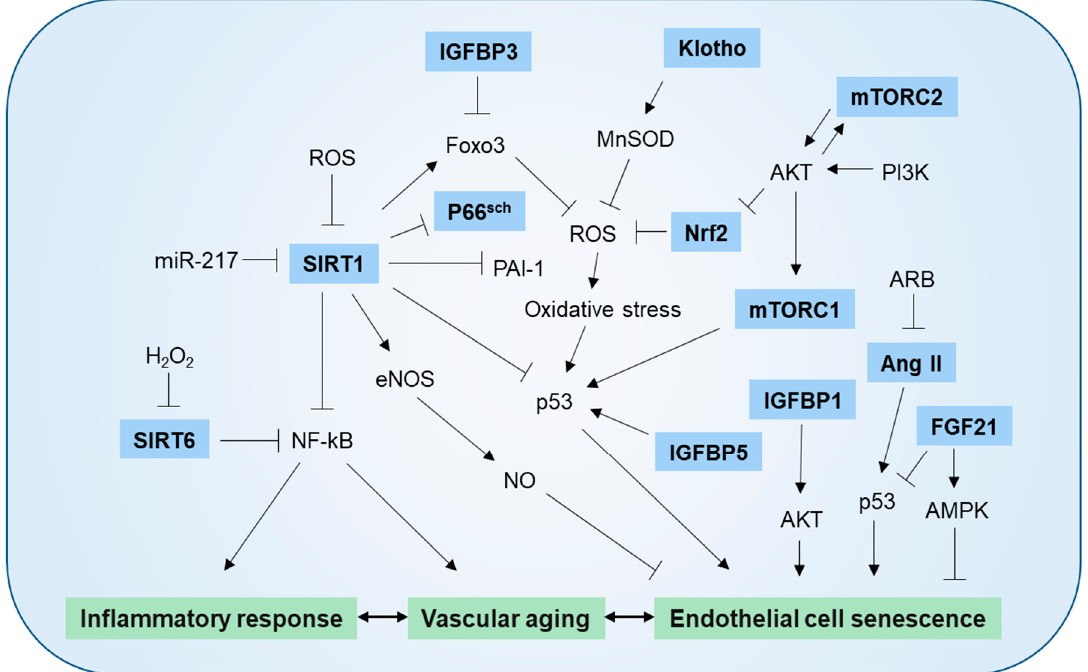
Figure 2. Molecular mechanism mediating endothelial cell senescence and vascular aging. SIRT1 protects against endothelial dysfunction by deacetylating eNOS and increasing endothelial NO bioavailability. SIRT1 also protects vascular inflammation by suppressing NF- κ B signaling and exerts anti-oxidant action by increasing Foxo and down-regulating p66shc. Under conditions of age-related overexpression, miR-217 suppresses SIRT1 production. Klotho increases MnSOD activity and NO availability by negatively downregulating IGF-1 signaling. H2O2 induces endothelial cell (EC) senescence via downregulation of SIRT6 levels. SIRT6 deficiency raises the expression of endothelial proinflammatory cytokines and increases NF- κ B transcriptional activity. Increased oxidative stress due to NRF2 deficiency promotes EC senescence. mTORC1 increases EC senescence through the PI3K/AKT pathway and mTORC2 induces EC senescence by suppressing NRF2 production via the AKT/GSK-3 β /CEBP α signaling pathway. IGFBP1 and IGFBP5 induce senescence in HUVECs through AKT or p53-dependent mechanism. IGFBP3 promotes EC senescence by inhibiting the SIRT1-Foxo axis, ARB inhibits Ang II-induced EC senescence, and FGF21 represses EC